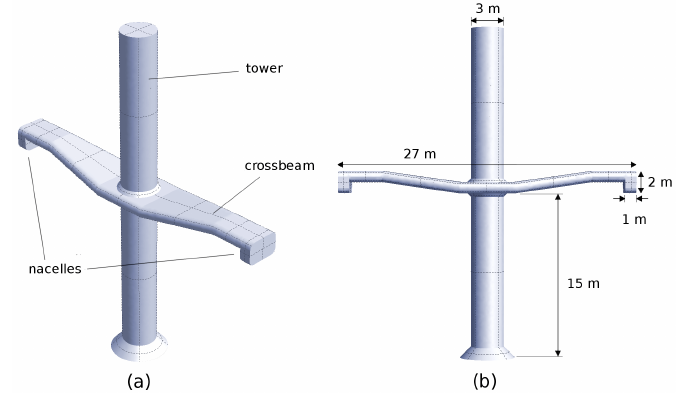
Figure 10. The turbine structure: ( a ) a perspective view illustrating the main components and ( b ) a head-on view indicating important dimensions.